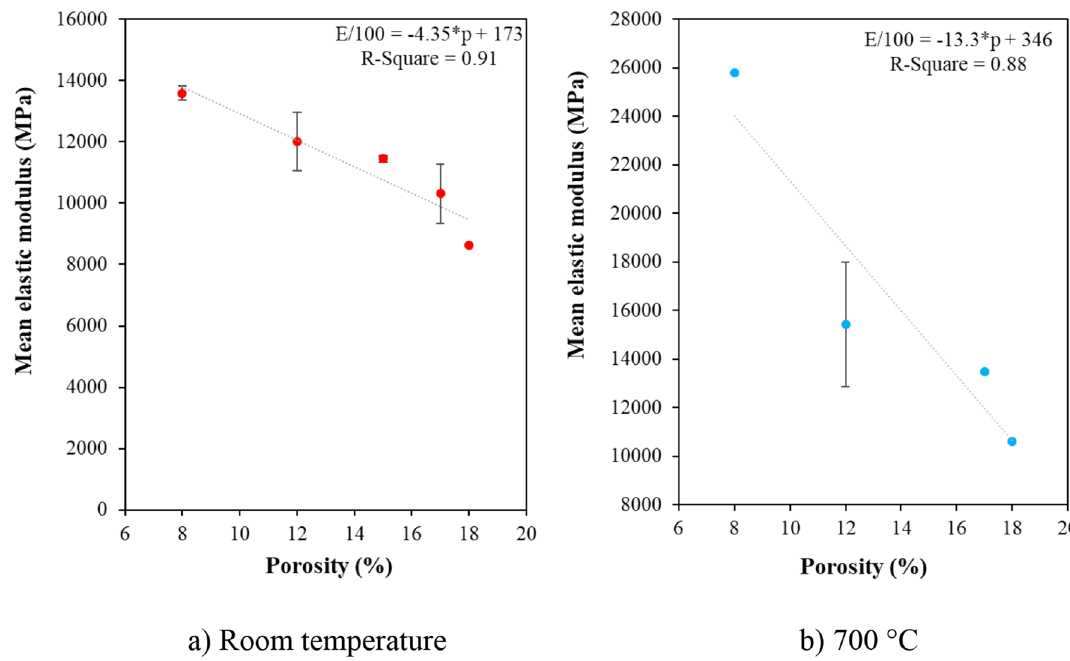
mulae are provided. Parameters E and p stand for elastic modulus and porosity, respectively